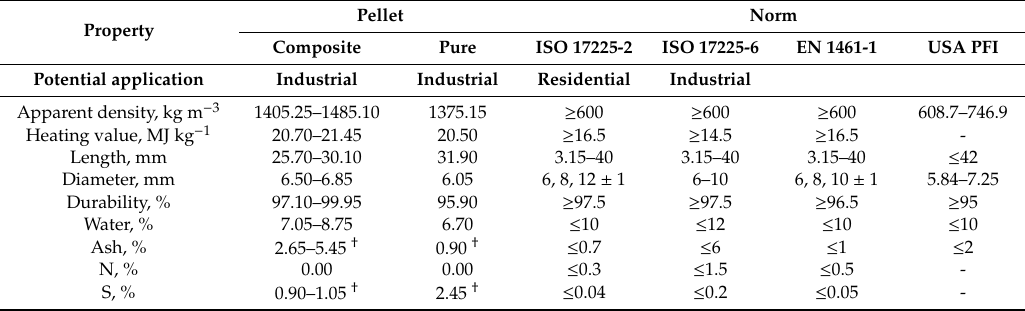
Table 4. Potential applications for the hybrid non-wood pellets from co-pelletization of sugarcane bagasse with residual biomass from distillation of cellulosic